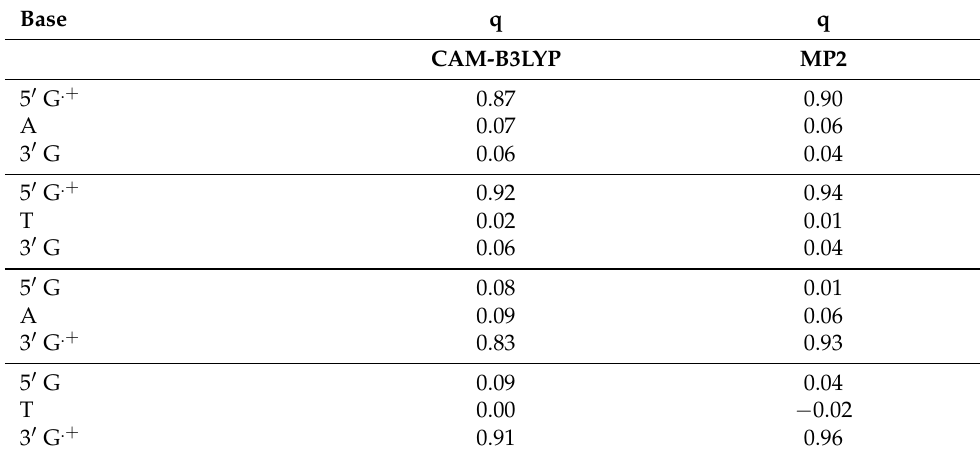
Table 1. ESP charges of (GAG) + and (GTG) + stacks. Two sets of ESP charges for each triplet are reported: one where the 5 (cid:48) Guanine is in its neutral relaxed geometry and the 3 (cid:48) Guanine in its cationic relaxed geometry and one where the Guanine geometries were swapped.